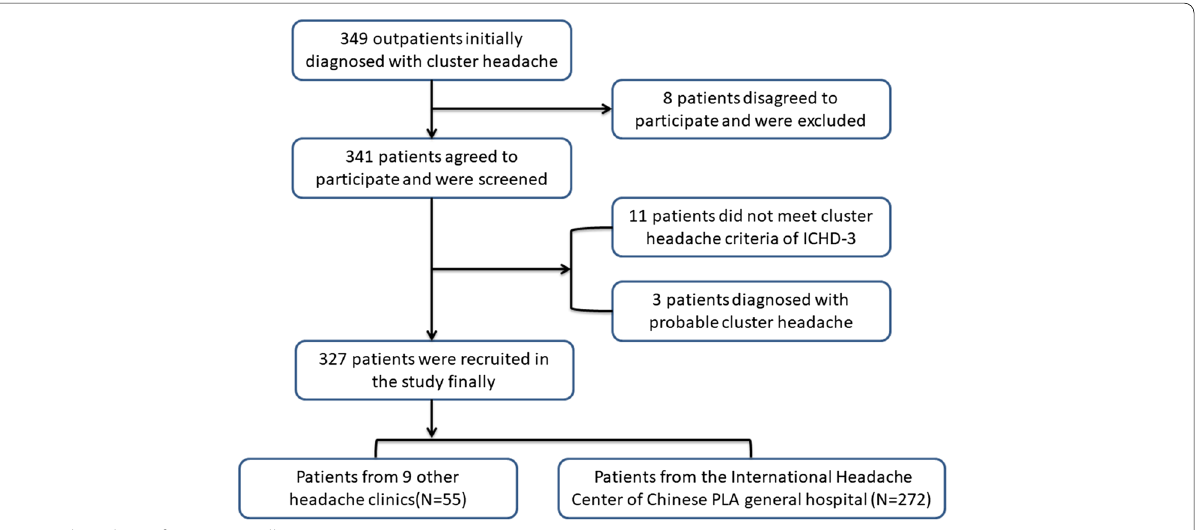
Fig. 1 Flow chart of patient enrollment